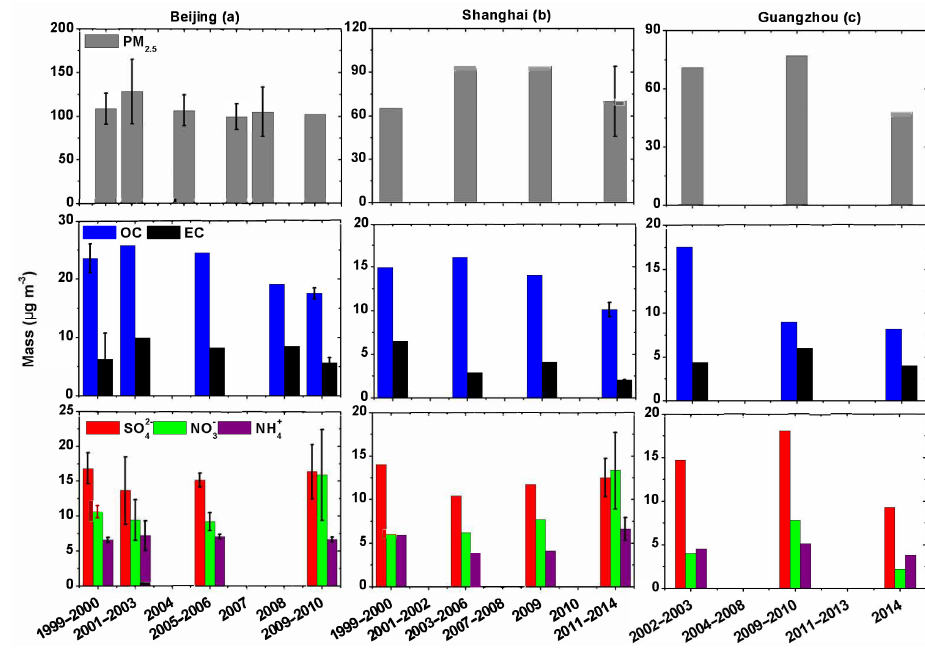
Figure 3. Interannual variations in PM 2 . 5 and dominant chemical components in Beijing (a) , Shanghai (b) and Guangzhou (c) .